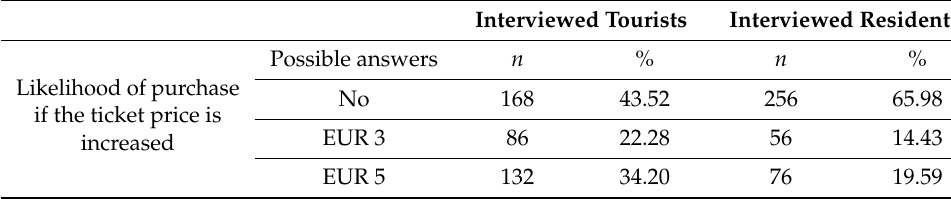
Table 4. Likelihood of purchase: interviewed tourists and interviewed